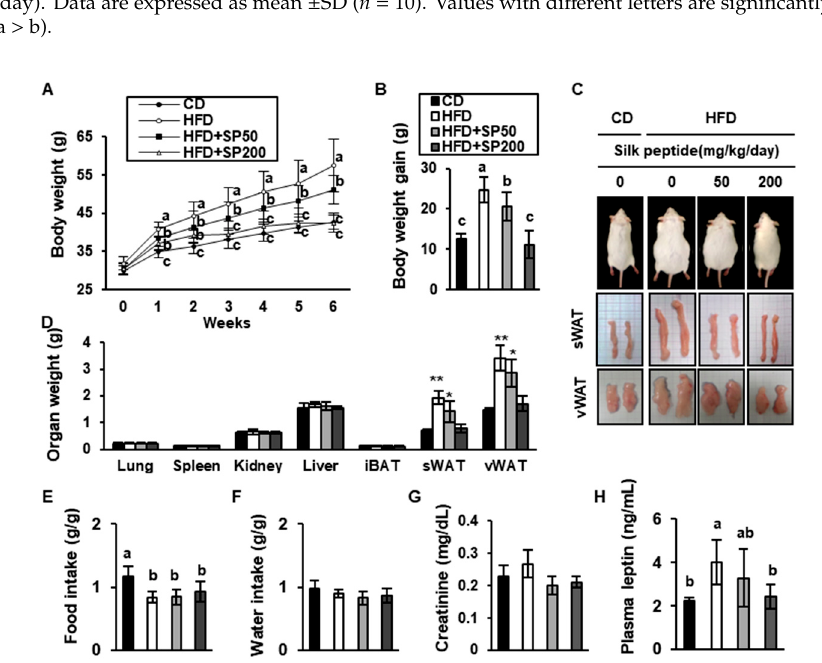
Table 4. E ff ect of silk peptide treatment on blood lipid parameters in HFD-induced obese mice. Blood Parameter (mg / dL) CD HFD HFD HFD Group Silk Peptide 0 * Silk Peptide 0 * Silk Peptide 50 * Silk Peptide 200 * Triglycerides 102.8 ± 5.3 b 120.5 ± 6.0 a 97.0 ± 20.0 b 98.3 ± 7.5 b Total cholesterol 94.5 ± 7.9 b 134.5 ± 5.4 a 87.3 ± 18.0 b 99.3 ± 19.0 b LDL cholesterol 11.5 ± 1.9 b 14.8 ± 2.5 a 9.0 ± 2.7 b 9.3 ± 2.2 b HDL cholesterol 120.0 ± 8.2 a 97.8 ± 6.4 b 110.3 ± 13.2 a b